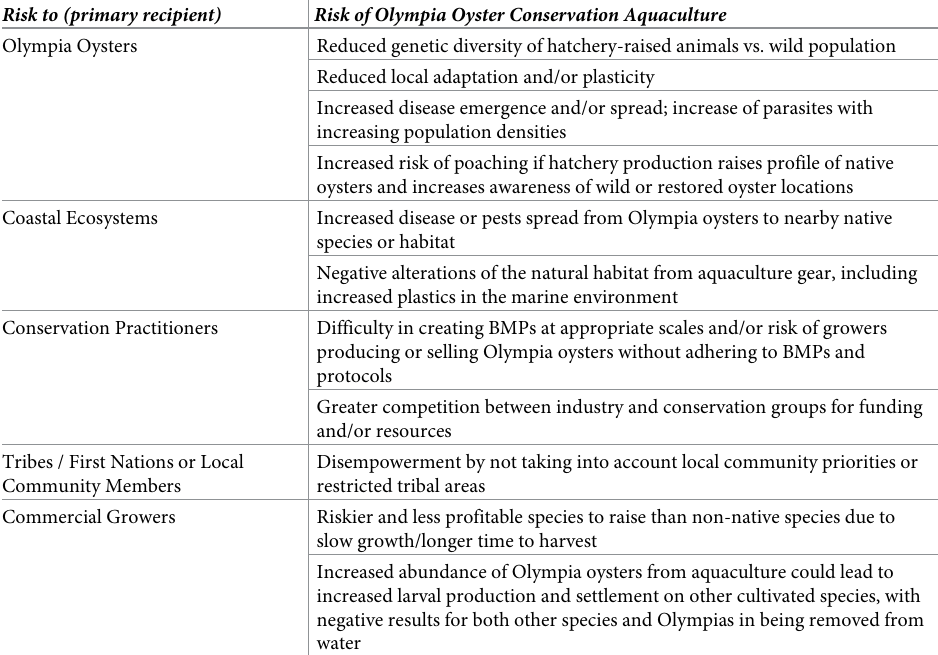
Table 3. Potential risks of conservation aquaculture of Olympia oysters, organized by primary recipient group.